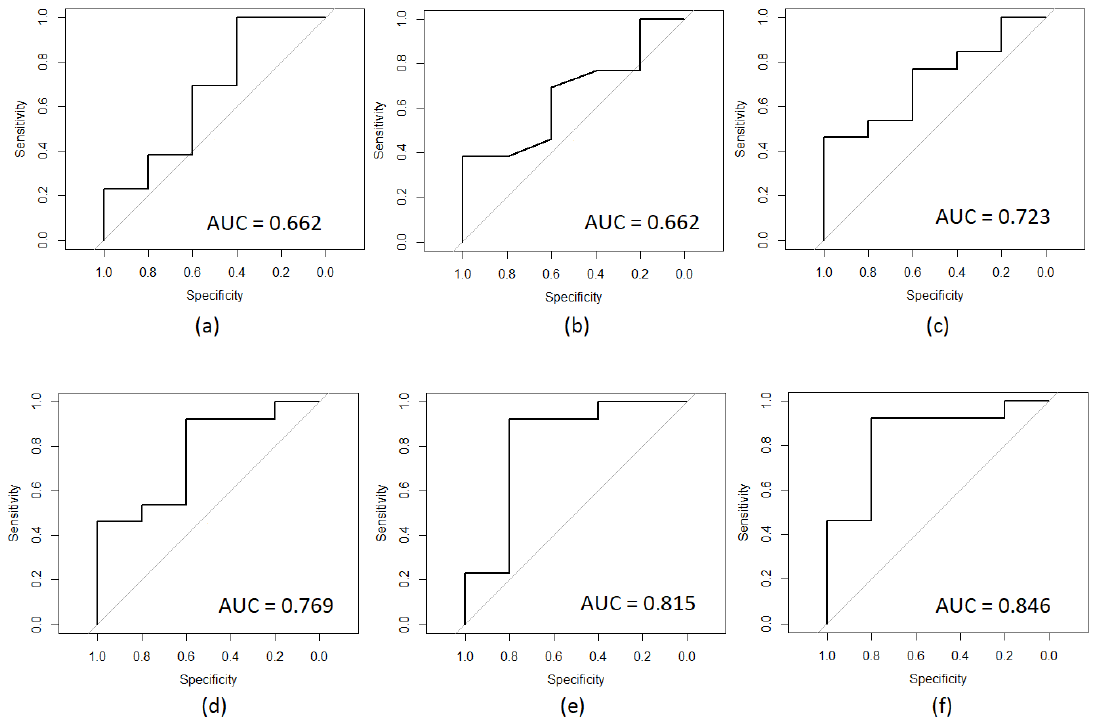
Figure 1. ROC curves obtained through the univariate models of the features that presented an AUC value higher than 0.650: ( a ) Isubutyric acid, ( b ) postnatal age weeks ( c ) butyric acid, ( d ) hexanoic acid, ( e ) valeric acid, and ( f ) acetic